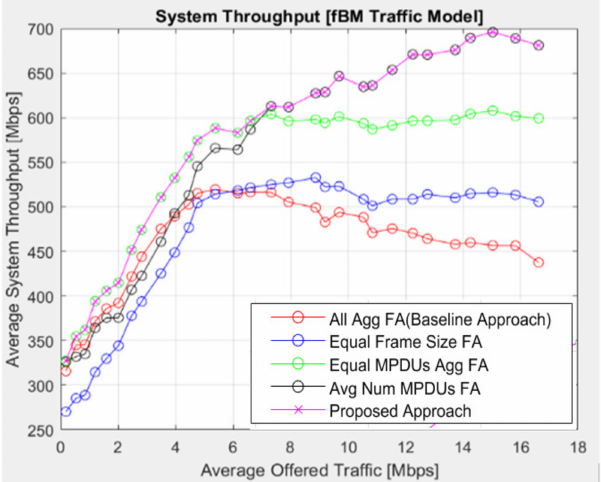
Figure 9. Performance of average system throughput with increasing offered traffic load using fBM traffic